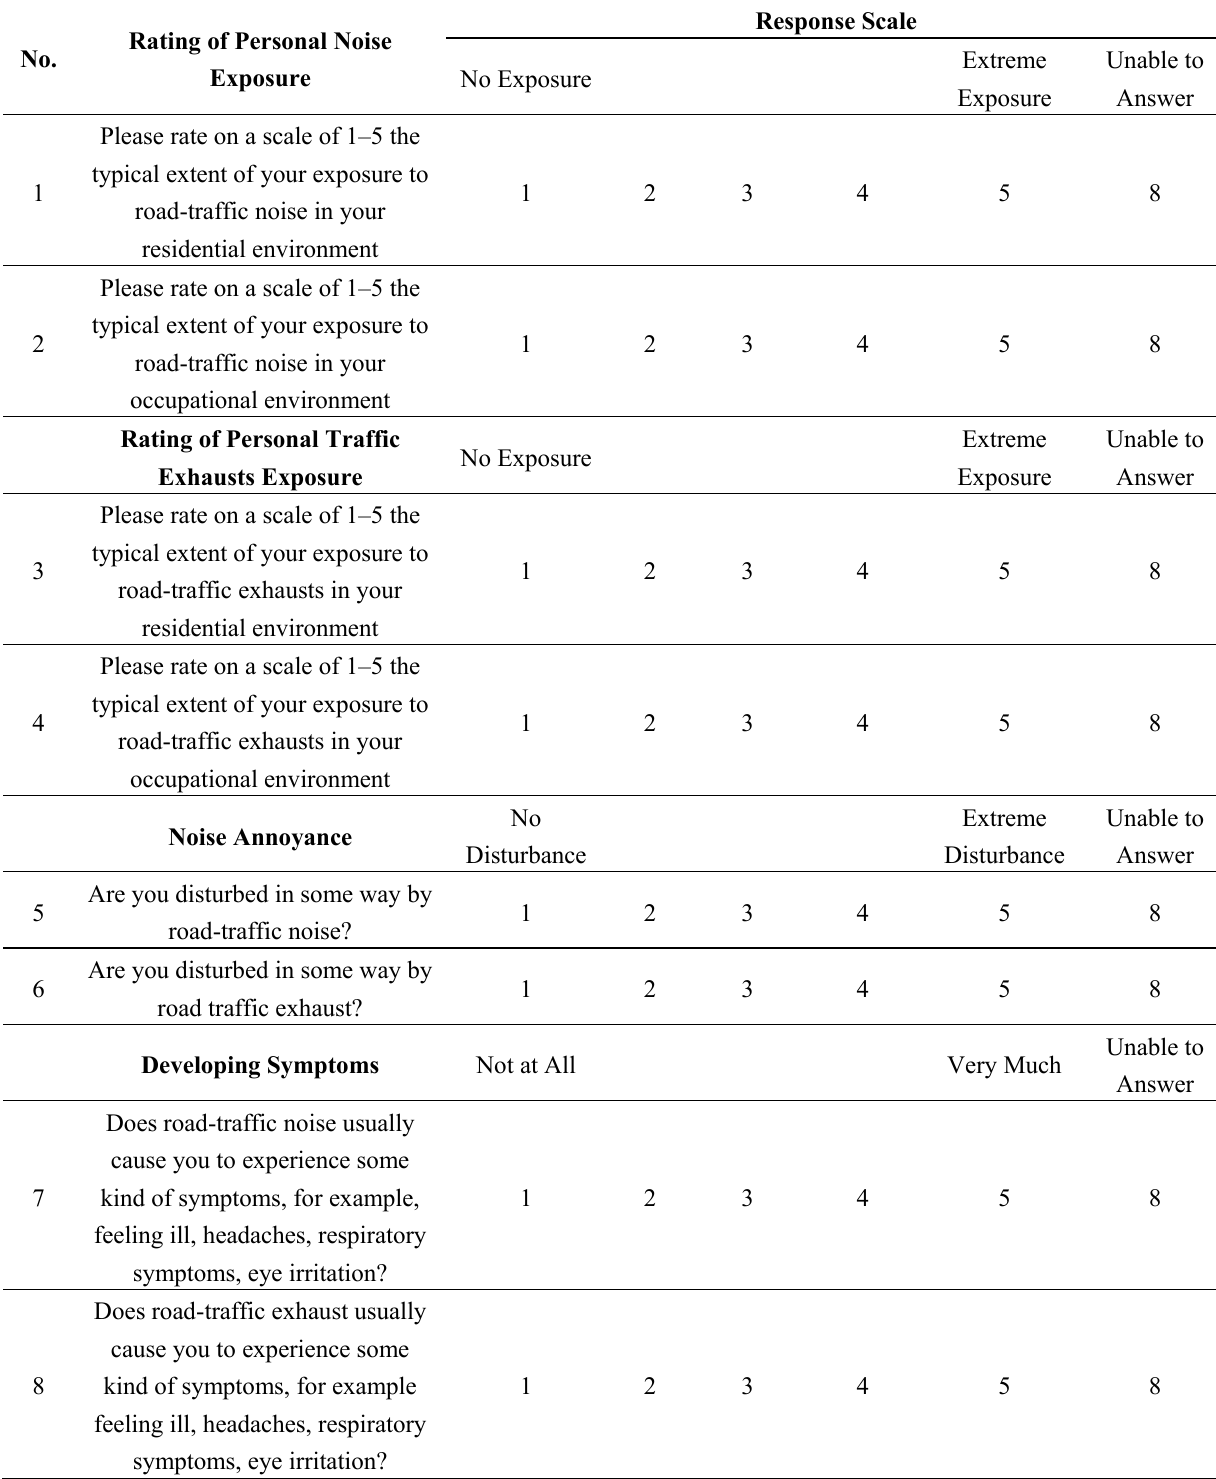
Table A1. Questionnaire items on key